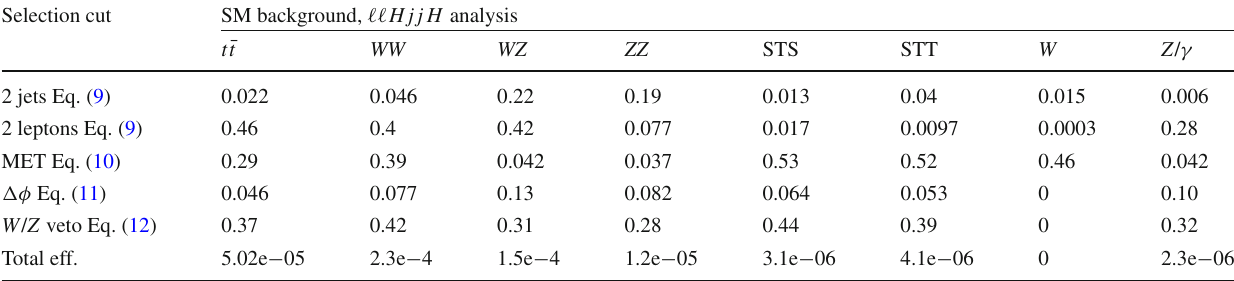
Table 5 Background selection efficiencies and the total efficiency for each background. STS and STT denote the single top s and t channels, respectively Selection cut